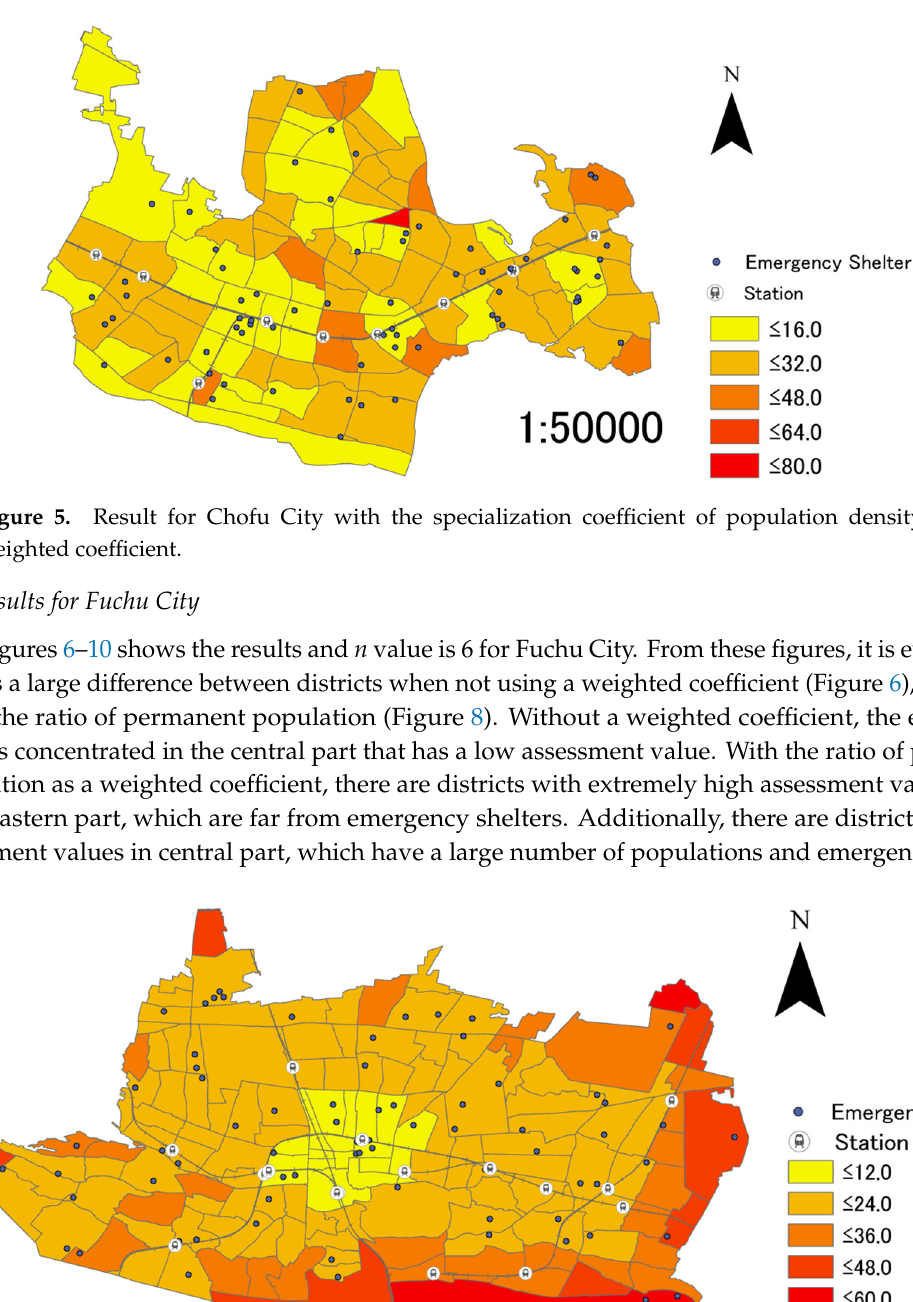
Figure 4. Result for Chofu City with the ratio of elderly population as a weighted coefficient.